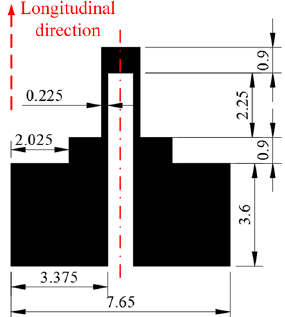
Figure 2. The dimensions of the strain gauge. Units: mm.